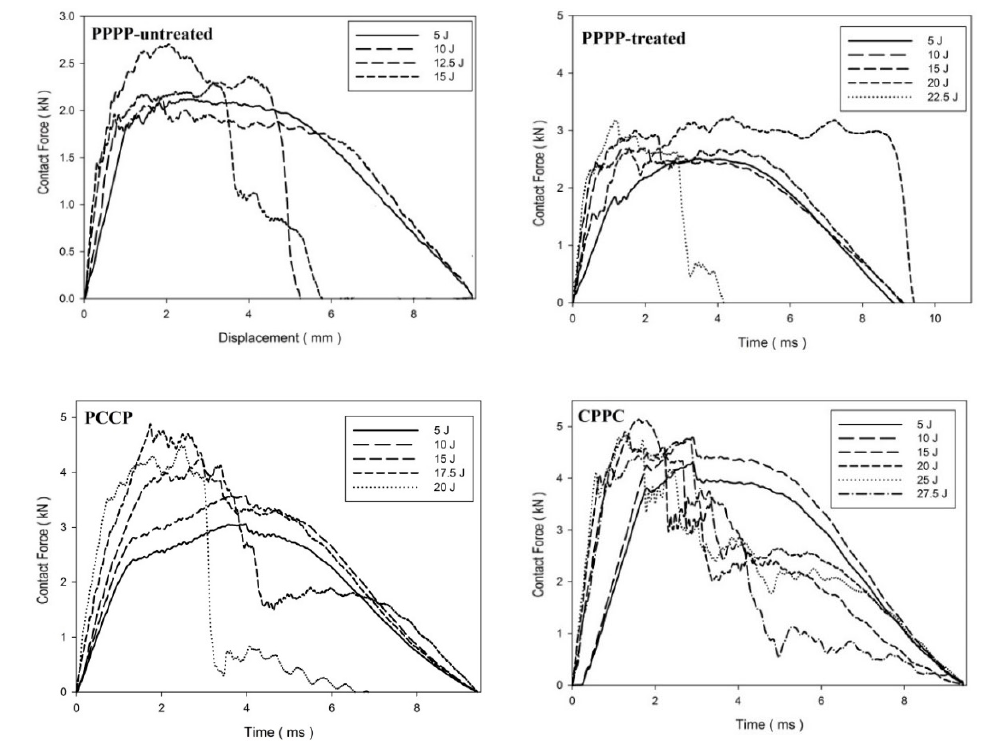
Figure 13. Contact force–time of the hybrid laminates at ply orientations of [0°/90° 2 , ±45° 2 ] s .